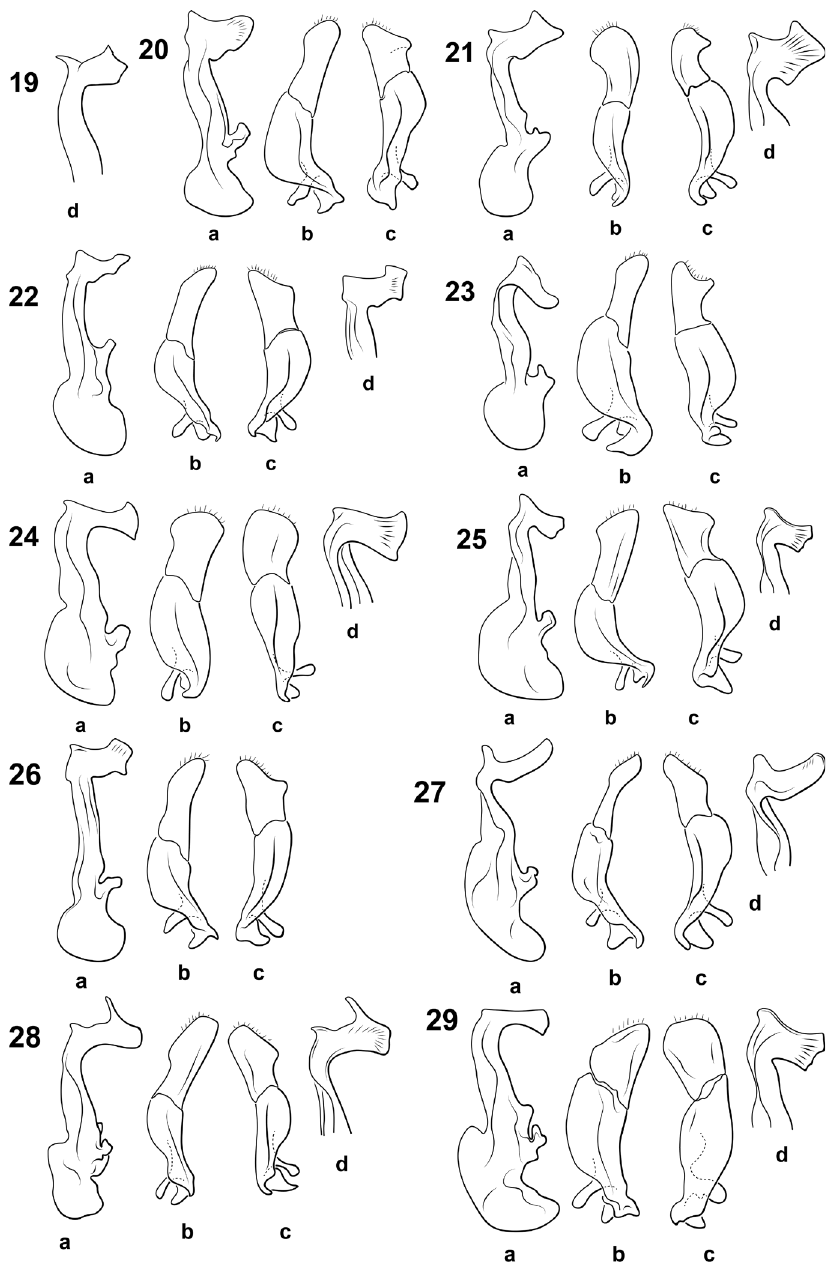
Figures 19–29. Bidessonotus species, male genitalia; A median lobe, right lateral aspect B right lat- eral lobe, right lateral aspect C left lateral lobe, apical segment, left lateral aspect D median lobe apex, oblique right lateral aspect 19 B. bicolor (redrawn from Guignot, 1957) 20 B. dubius 21 B. melanocephalus 22 B. obtusatus 23 B. otrerus 24 B. paludicolus 25 B. ploterus 26 B. rubellus 27 B. tibialis 28 B. truncatus 29 B. vicinus